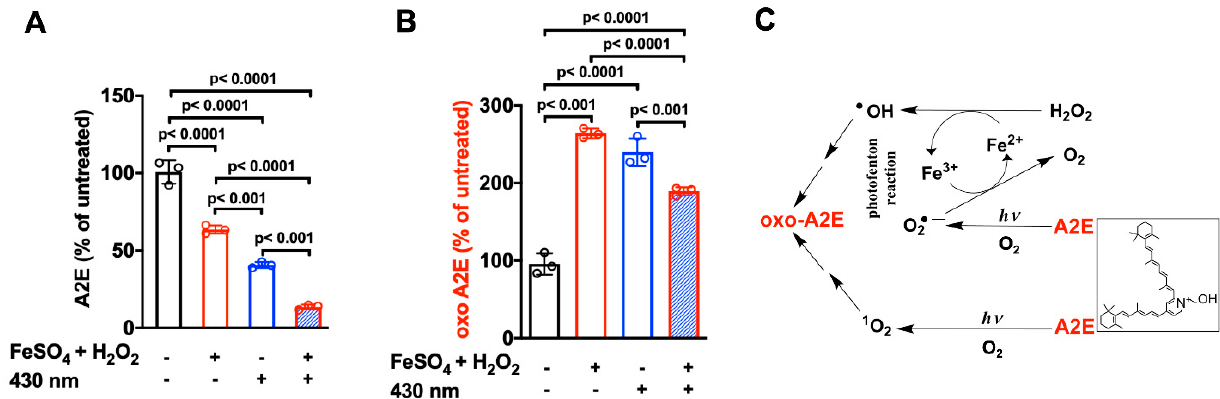
Figure 6. Synergistic effects of iron (Fe), hydrogen peroxide (H 2 O 2 ), and light ( hv ) in the oxidation of the bisretinoid A2E. ( A ) Photo-Fenton reaction and ( B ) UPLC quantitation of A2E and oxidized A2E (oxo-A2E) after incubation with FeSO 4 and H 2 O 2 , with and without 430 nm irradiation. Means ± SD, n = 3. P -values determined by two-way ANOVA and Tukey’s multiple comparison test. ( C ) Proposed mechanism: Hydroxyl radical ( • OH) generated by Fe 2+ and H 2 O 2 (Fenton reaction) oxidizes A2E and produces Fe 3+ . Fe 2+ is replenished by donation of an electron from the superoxide anion (O 2• − ); the latter forms via irradiation of A2E. Photosensitization of A2E generates O 2• − and singlet oxygen 1 O 2 , which also oxidize A2E. Adapted from [77] .